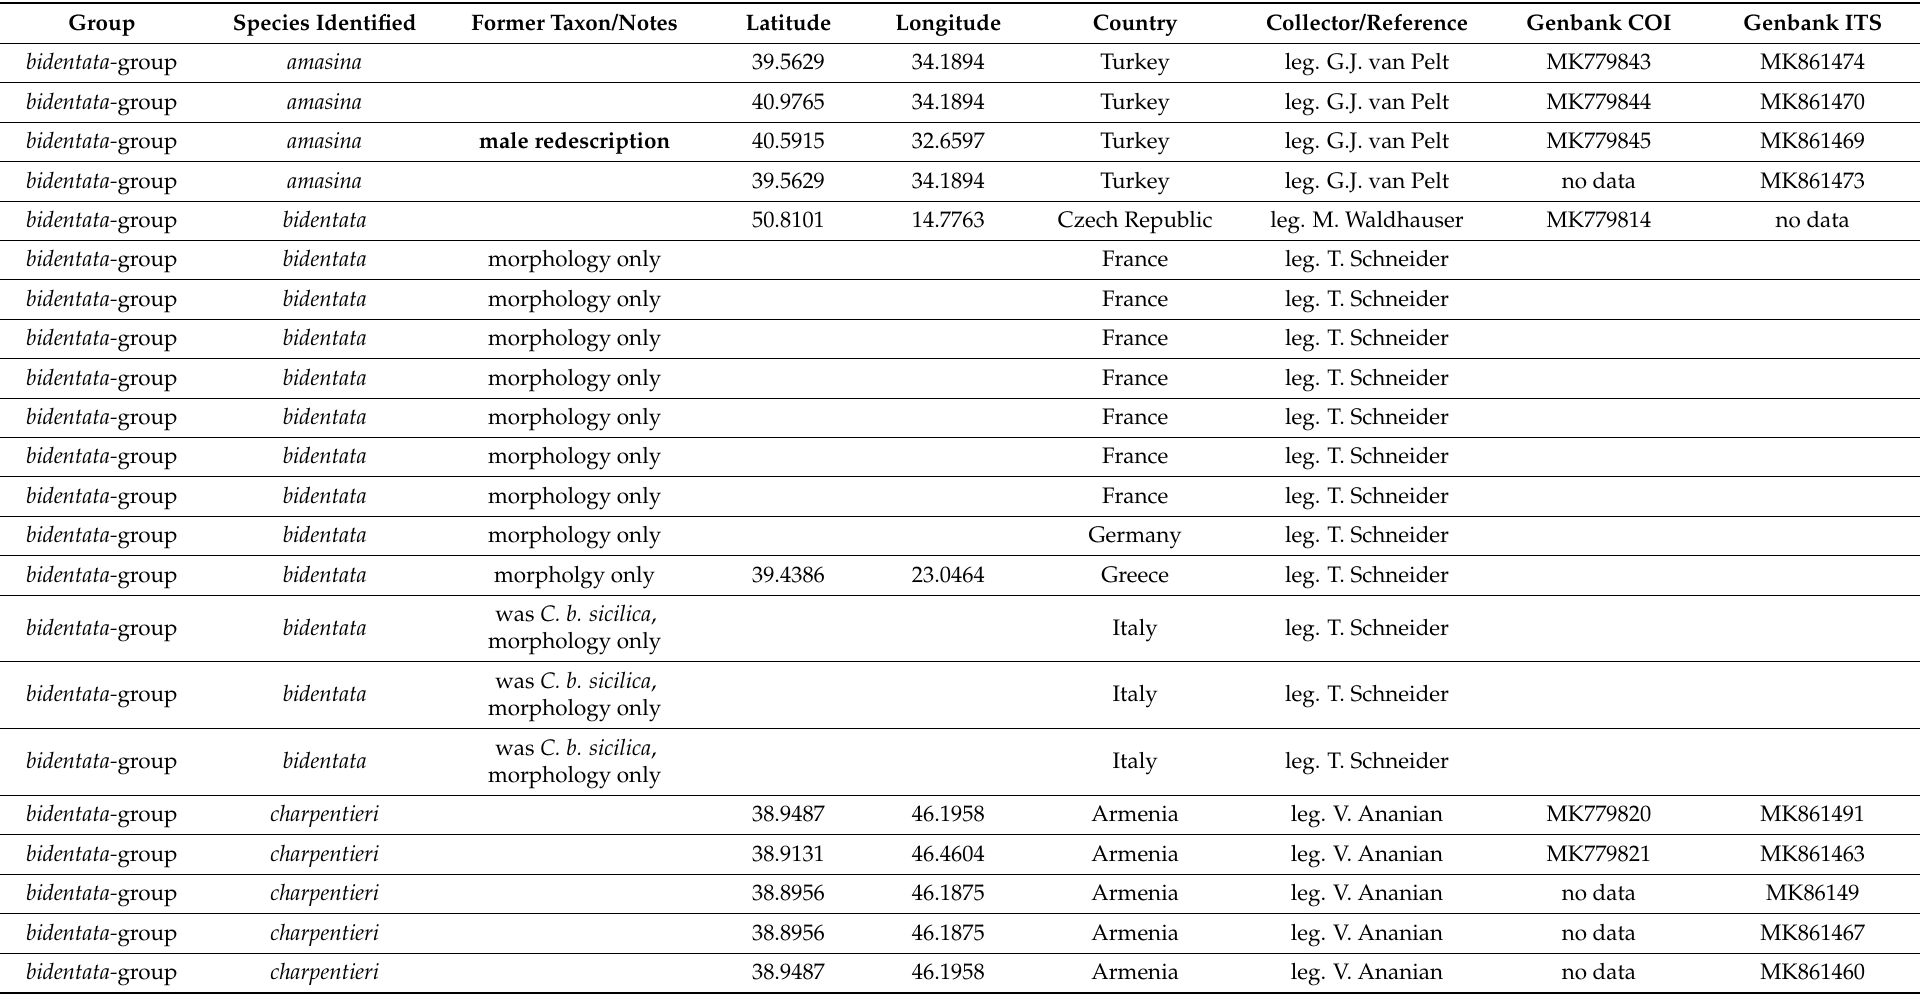
Table 1. Cordulegaster specimens investigated are listed here with group name, species names, notes, geo-coordinates, collectors, reference, and gene bank numbers. For further details see Figure